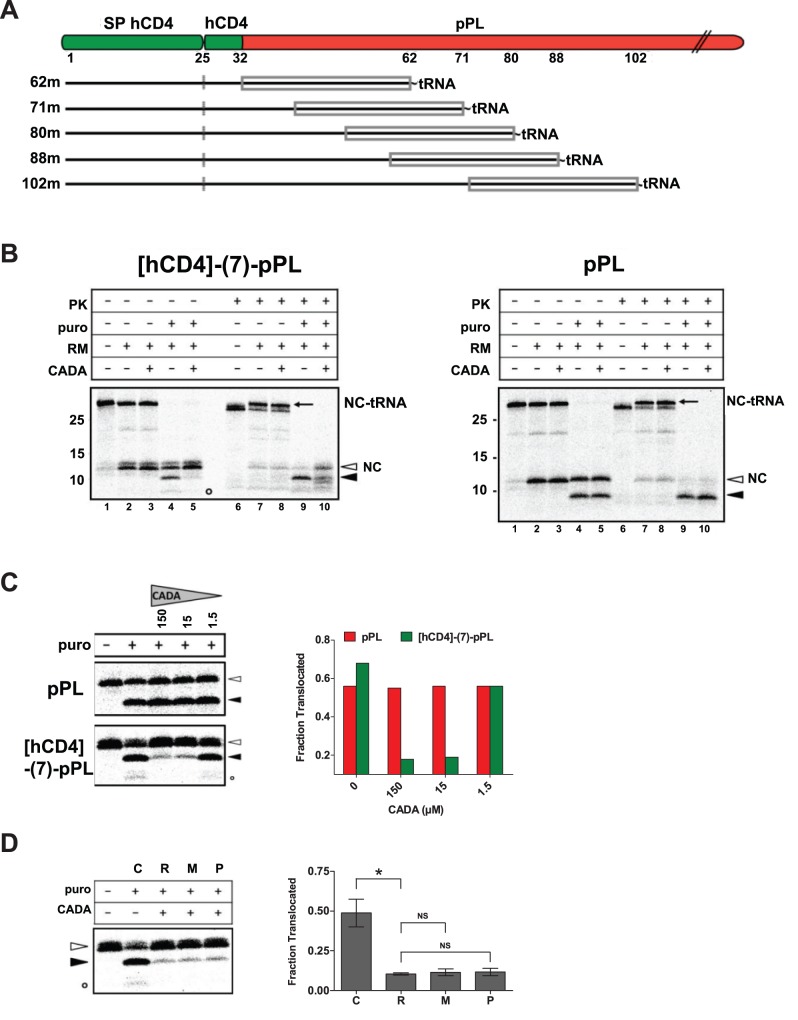
CADA inhibits co-translational translocation of hCD4-pPL at a post-targeting step.(A) Schematic representation of the truncated nascent chains of [hCD4]-(7)-pPL. The nascent chains remain attached to the ribosome through a peptidyl-tRNA bond. The (approximately) 30 residues at the C-terminus of the polypeptide that are buried inside the ribosome are indicated by a grey rectangle. The SP cleavage site (at residue 25) is also marked. (B) In vitro translation, targeting, translocation (puromycin-release), and PK digestion of [35S]methionine-labelled [hCD4]-(7)-pPL 80-mers (left panel) and WT pPL 78-mers (right panel). Intact peptidyl-tRNA bands (NC-tRNA, arrow) are indicated and represent the targeted and PK protected RNCs. Note that the presence of microsomes (RM) releases some nascent chains (NC) from tRNA in an unproductive way (compare lanes 1 and 2, open arrowhead). The positions of released precursor (open arrowhead) and signal-cleaved (solid arrowhead) polypeptide chains are indicated. The SP of hCD4 but not pPL was also detected (open circle). Molecular mass is in kDa. (C) Dose response of CADA (µM) on translocation of RNCs as in (B). Graph shows translocation fractions of the autoradiogram quantified by phosphorimager analysis. (D) Time of addition of CADA. [hCD4]-(7)-pPL nascent chains of 80 residues (80-mers) were synthesized in the absence of membranes before exposure to RM for targeting. Nascent chains were left untreated (C, control), or were treated with CADA (15 µM) either administered at the beginning of the synthesis in the translation mixture (R, ribosomes), administered to membranes for pretreatment (M, microsomes), or applied to the RNC/RM mixture 15 minutes after initiation of targeting but before puromycin release (P, post-targeting). Graph shows translocation data of three experiments quantified by phosphorimager analysis. NS, not significant. *p<0.01.